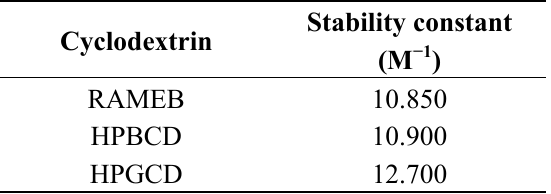
Table 2. Stability constants for Gen